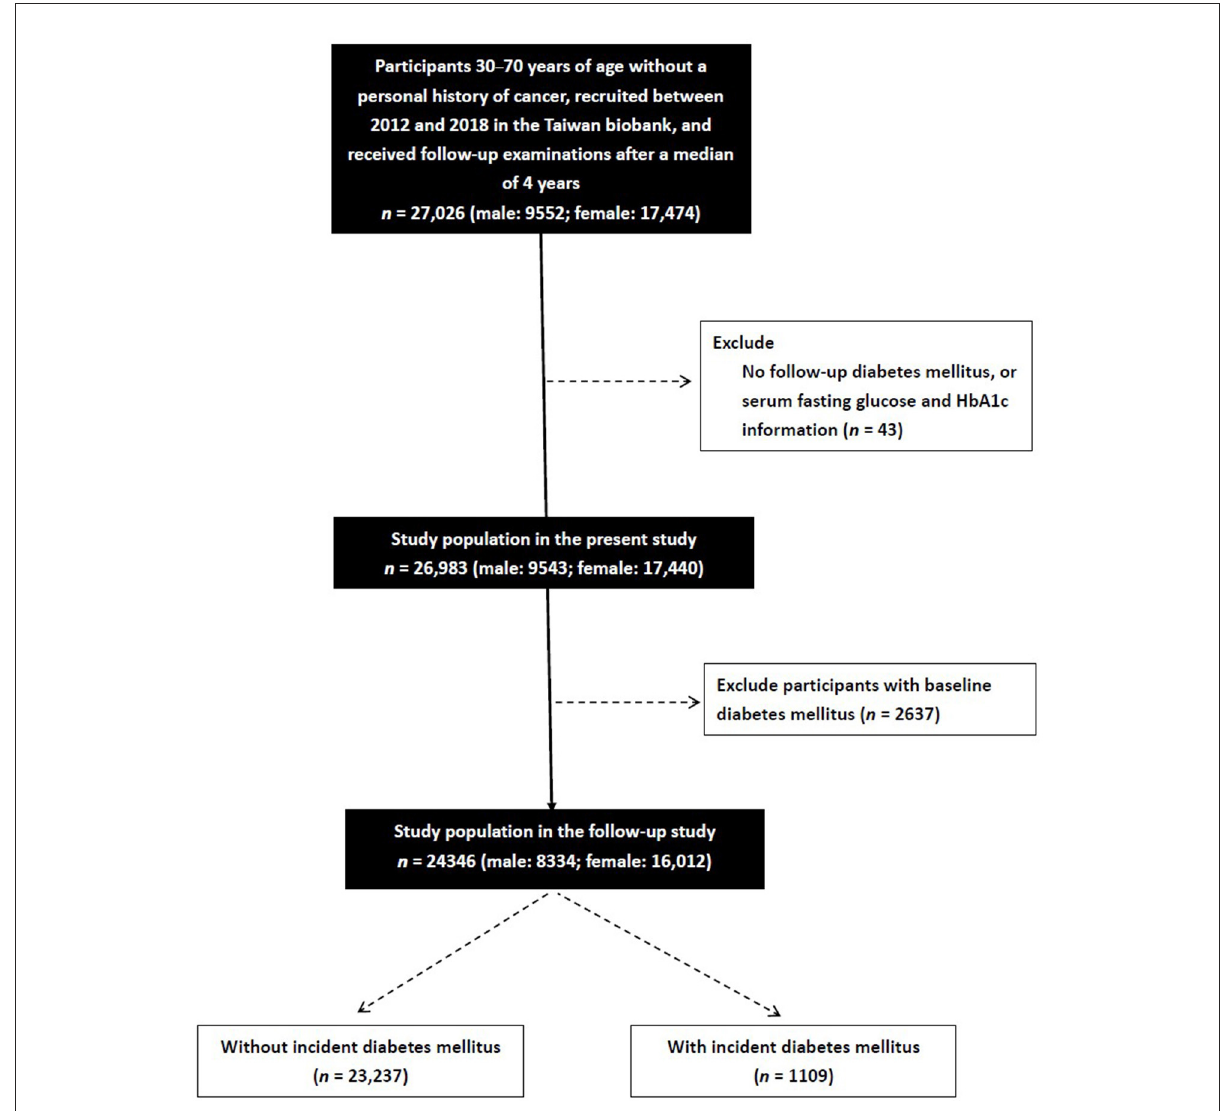
FIGURE1 Flowchart of study